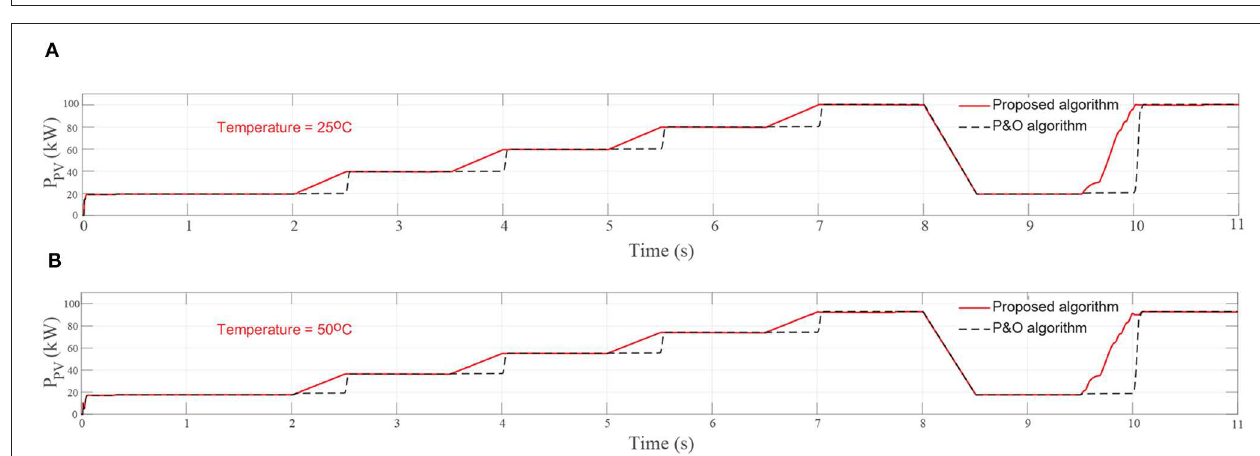
FIGURE 7 | Simulated signal waveform of (A) the rapid change of solar irradiation; and (B) the slow change of solar irradiation.